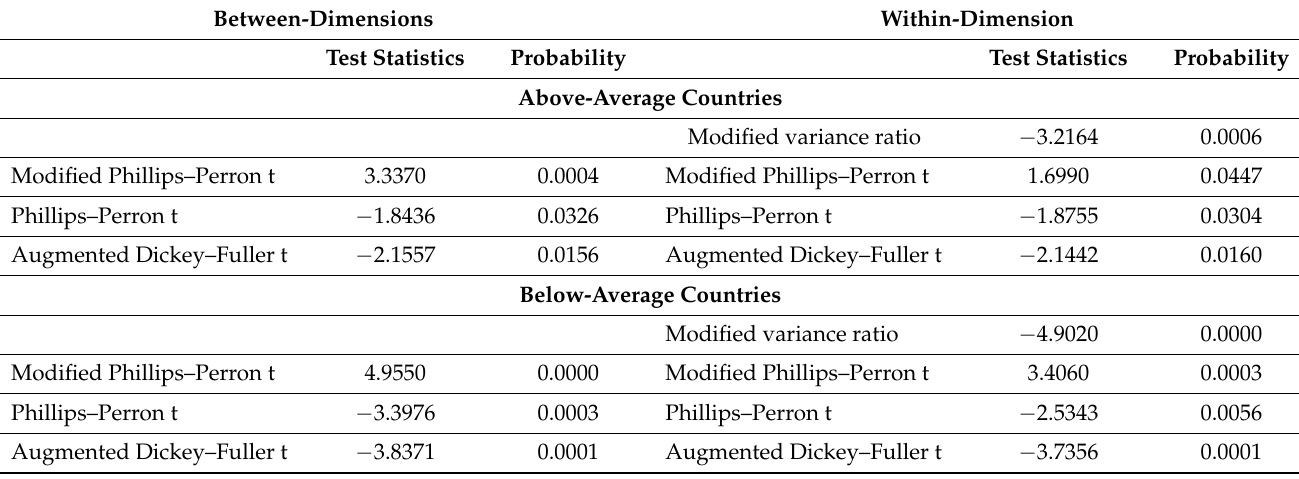
Table 5. Pedroni cointegration test results. Source: